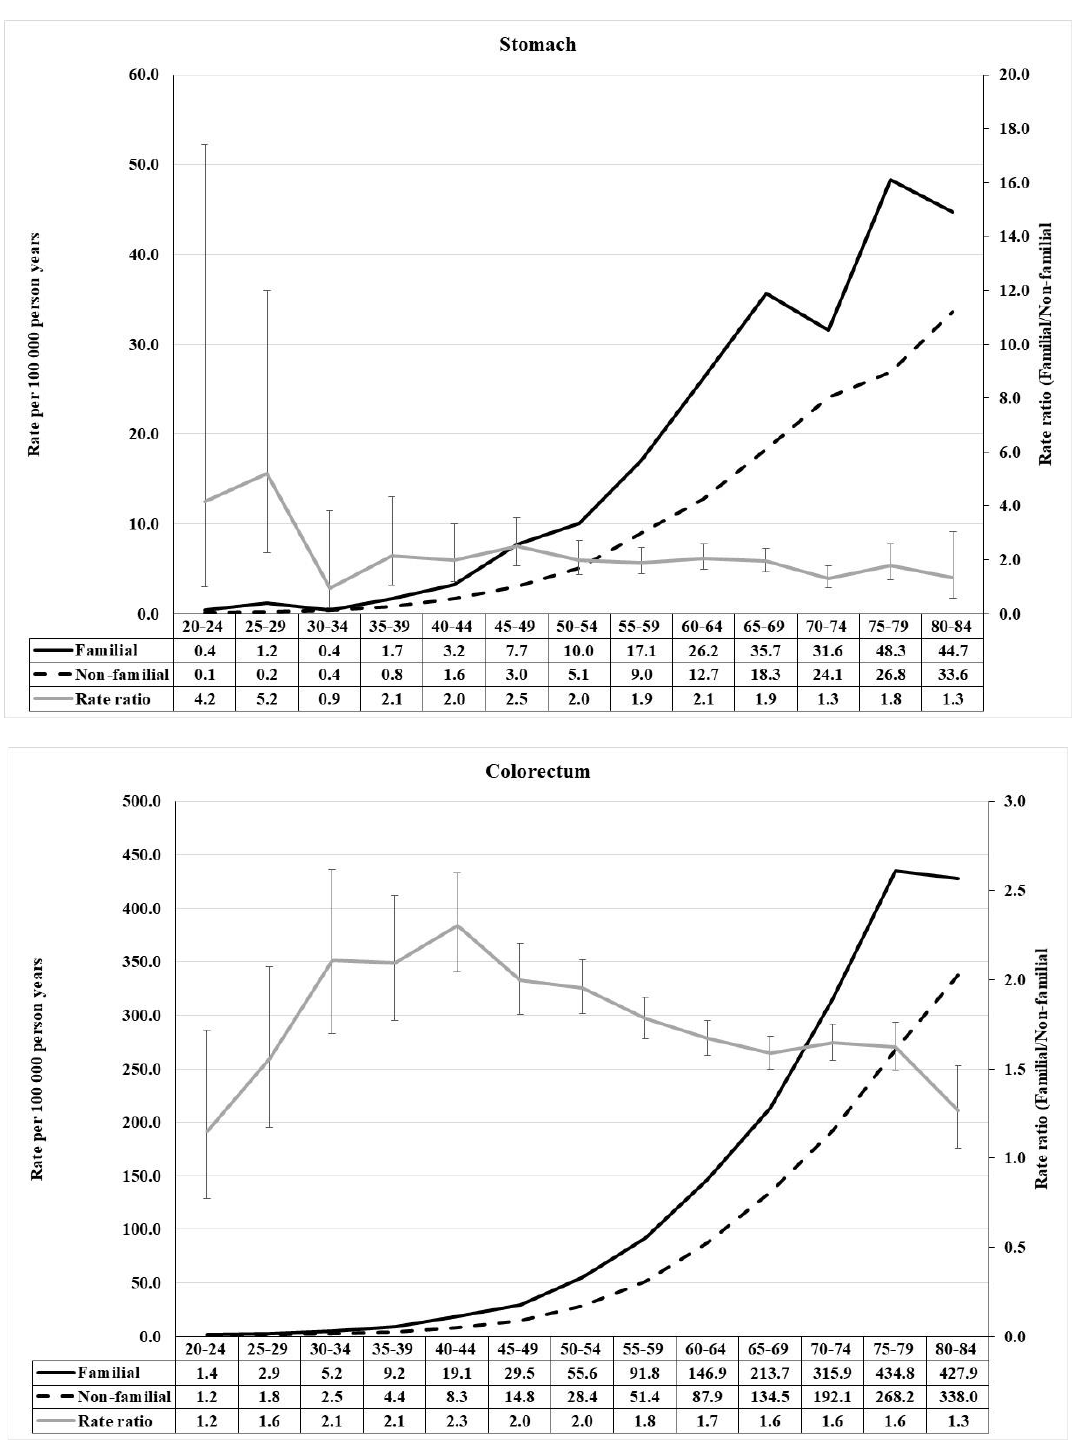
Figure 1. Age-specific incidence rate and rate ratio of stomach ( upper ) and colorectal ( lower ) cancer in population with and without family history of concordant cancer.